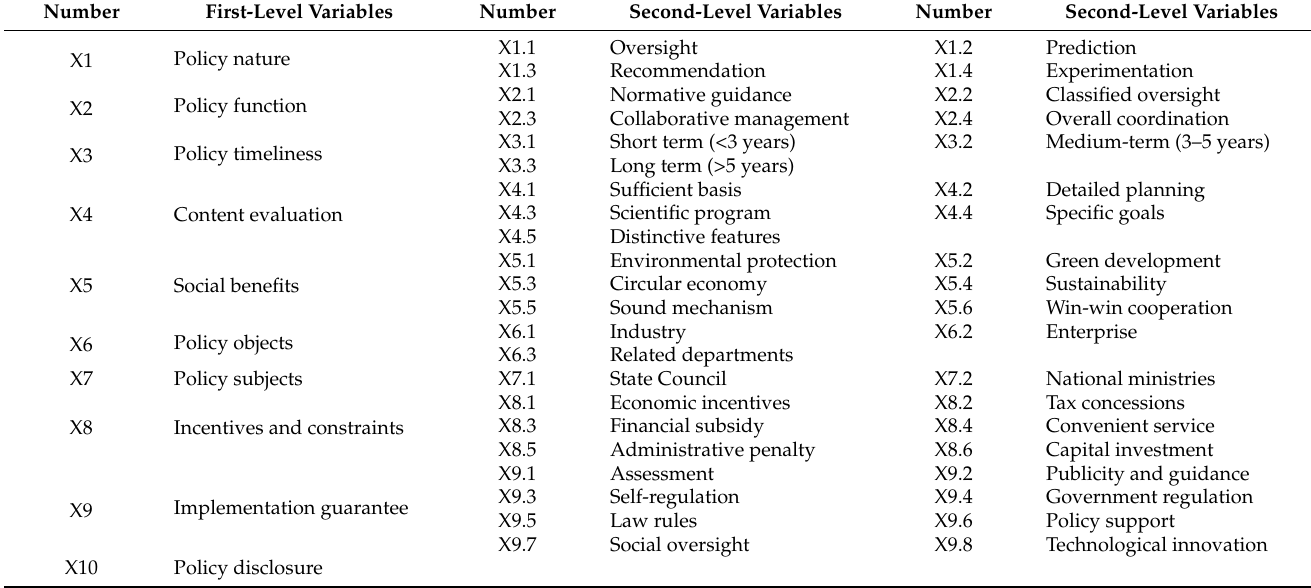
Table 2. Policy variable